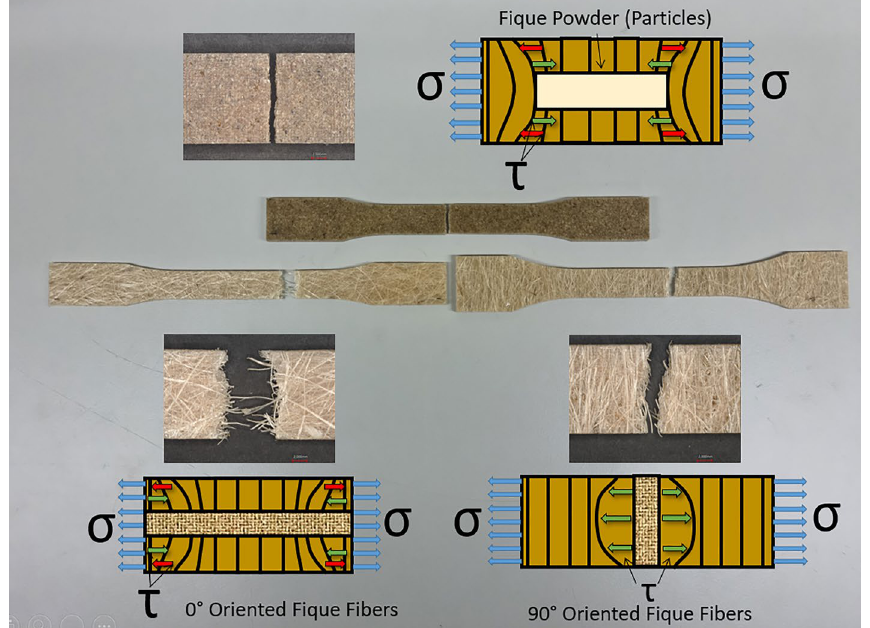
Figure 6. Fracture modes observed in EP-FP, EP-UF 0°, EP-UF 90°composites after tensile